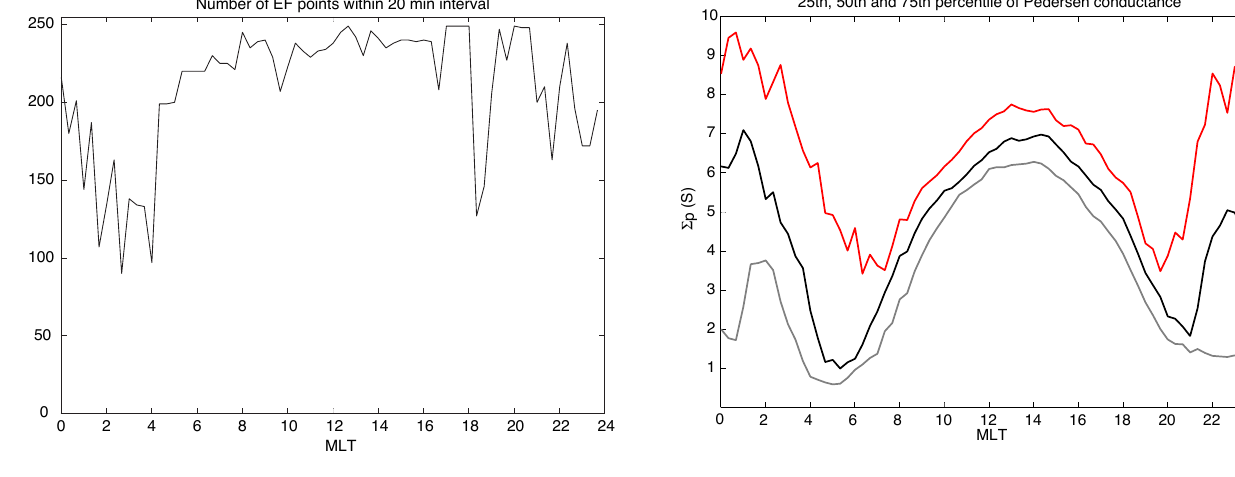
Fig. 2. Number of 2-min samples used in 20-min windows of elec- tric field and Joule heating MLT plots.